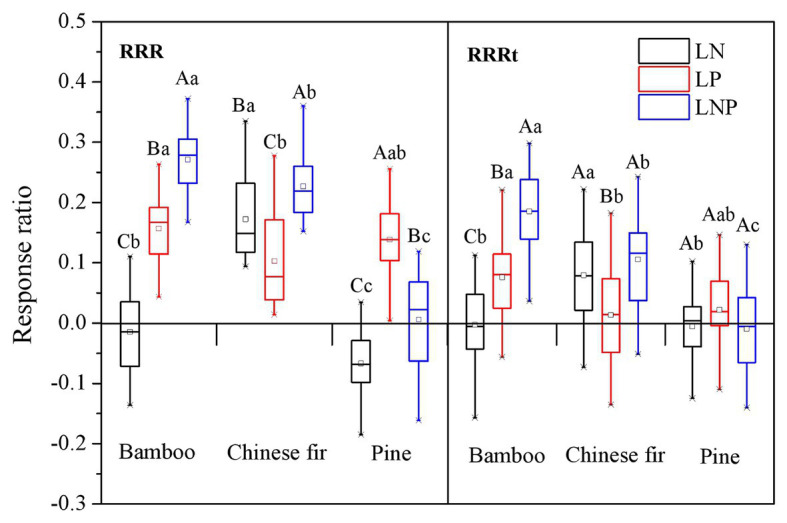
Response ratios (RRR and RRRt) under localized nutrient supply treatments (LN, LP, and LNP) in comparison to the uniform nutrient supply (UNP). Different lowercase letters denote significant differences among species (p < 0.05). Different capital letters denote significant differences among treatments (p < 0.05). RRR, root response ratio; RRRt, response ratio of total root length.